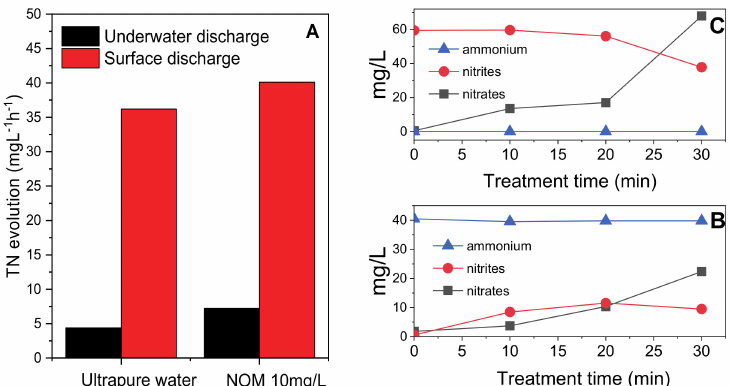
Figure 5. Comparison between the TN accumulation rate during treatment with surface and un- derwater discharge for a solution of ultrapure water and for a solution of NOM 10 mg/L ( A ); Concentration of ammonium, nitrite and nitrate ions over 30 min treatment with surface discharge in a solution on ammonium 40 mg/L ( B ) and in a solution of nitrite 60 mg/L ( C